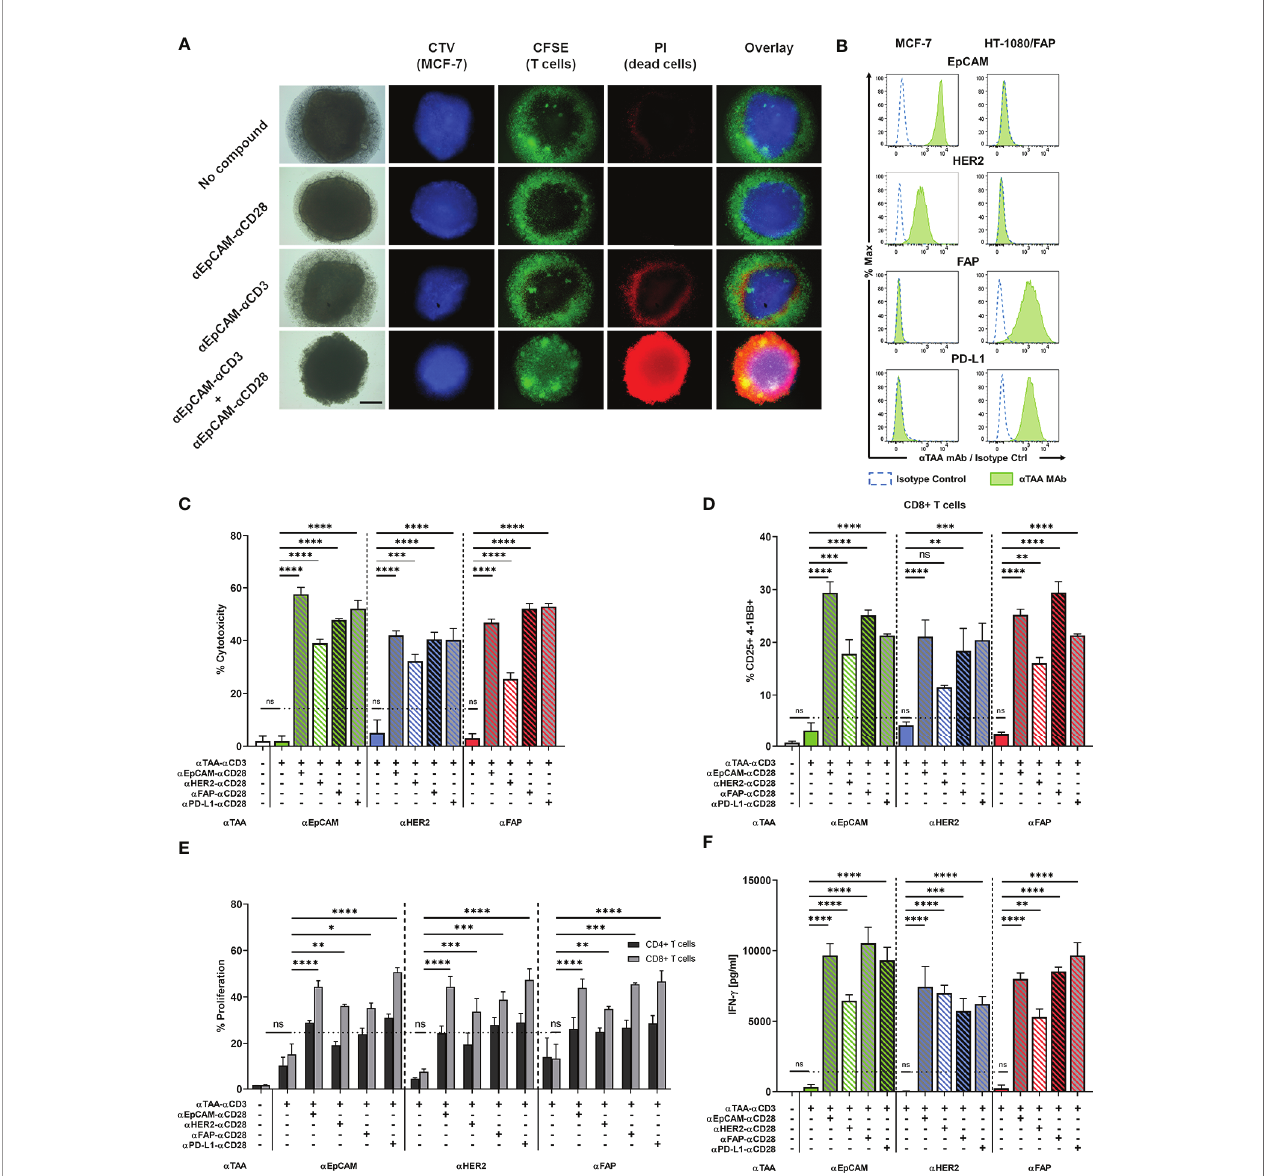
FIGURE 4 | A split co-stimulation approach targeting TAAs on different target cells enhances T cell activation in a mixed MCF-7 + HT-1080/FAP tumor spheroid model. (A) Fluorescence microscopy of MCF-7 spheroids after incubation with or without 10 nM of a CD3 +/- a CD28 BiMAb. Representative images of CTV-labelled MCF-7 spheroids. Puri fi ed T cells were labeled with carboxy fl uorescein succinimidyl ester (CFSE). Cell death was visualised by PI staining. The scale bar represents 250 µm. (B) EpCAM, HER2, FAP and PD-L1 surface expression on MCF-7 and HT-1080/FAP cells, respectively, analyzed by fl ow cytometry. Cell surface staining with isotype control antibodies (dotted blue line) and a TAA mAb (green fi lled). (C – F) Tumor spheroids from 5x10 4 mixed MCF-7 and HT-1080/FAP cells (1:1 ratio) were co-cultured with puri fi ed unstimulated T cells (10 5 cells per 96-well) and combinations of a TAA – a CD3 +/- a TAA – a CD28 BiMAb at 10 nM fi nal concentration. TAA reactivities included EpCAM, HER2, FAP and PD-L1. (C) Supernatants were collected after 48h of co-culture and tumor cell lysis was assessed via LDH release assay. (D) BiMAb-mediated CD8 + T cell activation was detected by fl ow cytometry based on surface co-expression of CD25 and 4-1BB. (E) Frequencies of proliferating CD4 + and CD8 + T cells were measured by fl ow cytometry (dilution of CTV labeling) after 5 days of incubation. a TAA – a CD3 treatment was statistically compared with the no compound control, a TAA – a CD3 + a TAA – a CD28 combinations were compared with a TAA – a CD3. Co-stimulation signi fi cantly enhanced CD8 + T cell proliferation for all settings (statistics indicated in fi gure). Enhancement of CD4 + T cell proliferation was signi fi cant only for the combinations a EpCAM – a CD3 + a EpCAM – a CD28 (*), a EpCAM – a CD3 + a PD-L1 – a CD28 (*), a HER2 – a CD3 + a EpCAM – a CD28 (*), a HER2 – a CD3 + a FAP – a CD28 (**), and a HER2- a CD3 + a PD-L1- a CD28 (***). (F) Concentrations of IFN- g (in pg/ml) in cell culture supernatants after 48 h of co-culture were determined by ELISA. Data represent mean values ± SEM from 3 independent experiments done in duplicates. Statistical analysis by one-way ANOVA (C, D, F) or two-way ANOVA (E) , both followed by Tukey ’ s multiple comparison test; ns, not signi fi cant; * p < 0.05; ** p < 0.01; *** p < 0.001; **** p <